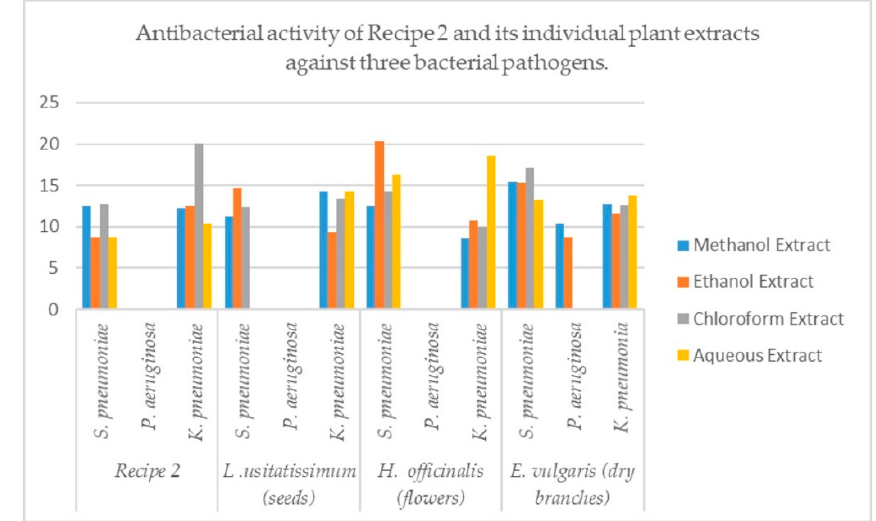
Figure 3. Comparative antibacterial activities of methanol, ethanol, chloroform and aqueous extracts of the L. usitatissimum (seeds), H. officinalis (flowers) and E. vulgaris (dry branches) and their Recipe 2. Each column represents the mean value of three independent replicates and the error bars indicate standard deviation.